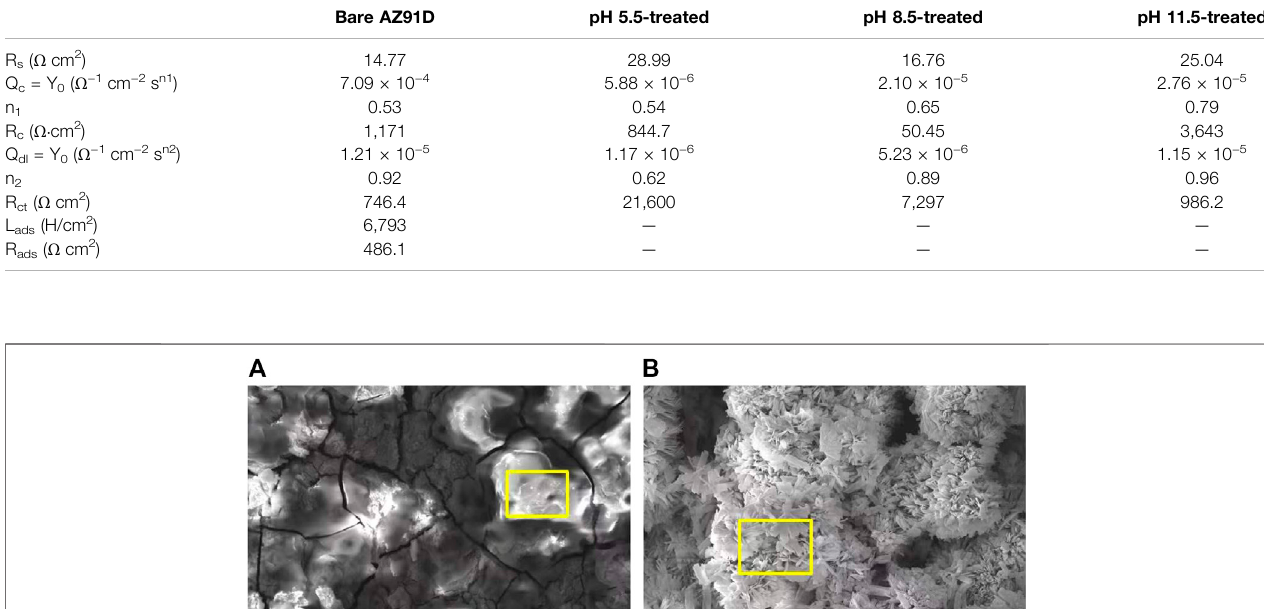
Frontiers in Chemistry |